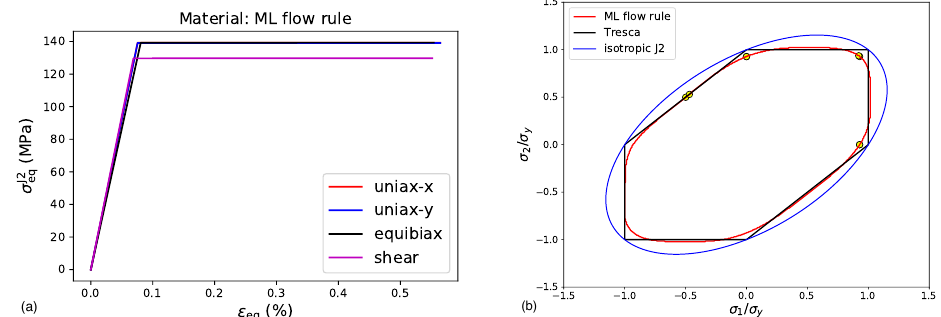
Figure 9. Results of FEA on the material with an ML flow rule trained with data obtained from a Tresca yield criterion: ( a ) Equivalent J2 stress plotted over the equivalent total strain, for the four different load cases given in Table 2. ( b ) Flow stresses obtained with the ML yield function plotted as yellow circles in the σ 1 - σ 2 principle stress space, together with the yield loci of the ML flow rule, the Tresca flow rule and an isotropic J2 flow